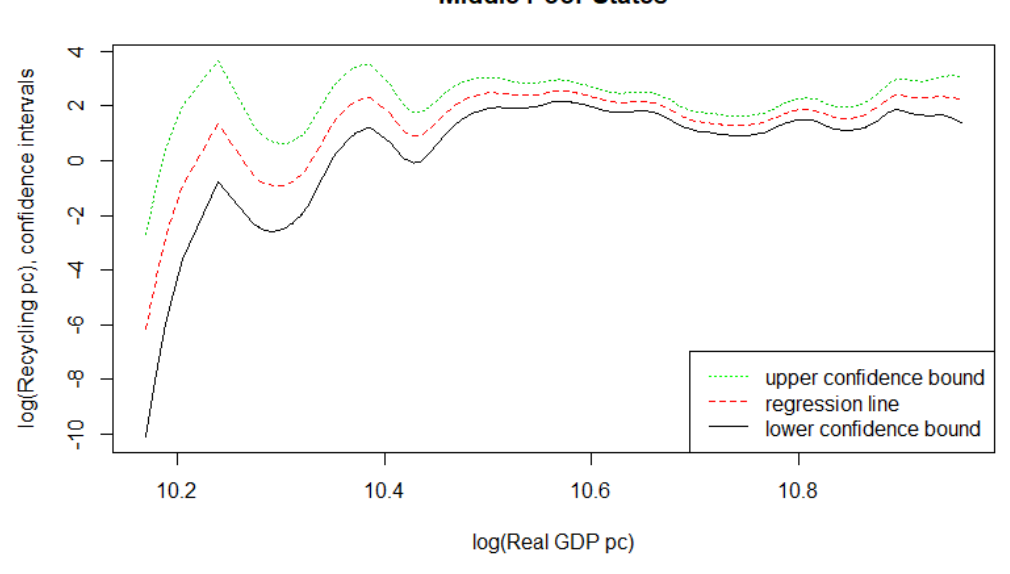
Figure 4. Relationship between Recycling per capita and Real GDP per capita for middle poor